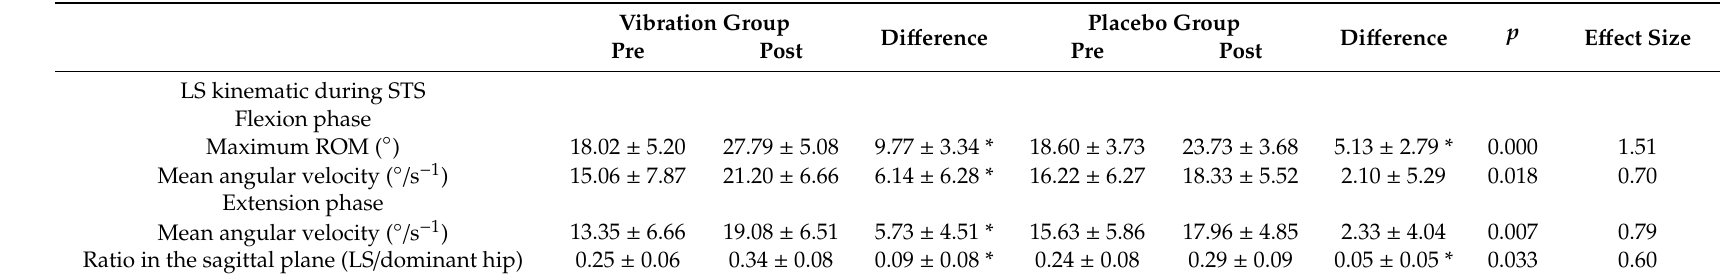
Table 3. Subject scores of LS kinematic during STS before and after intervention.